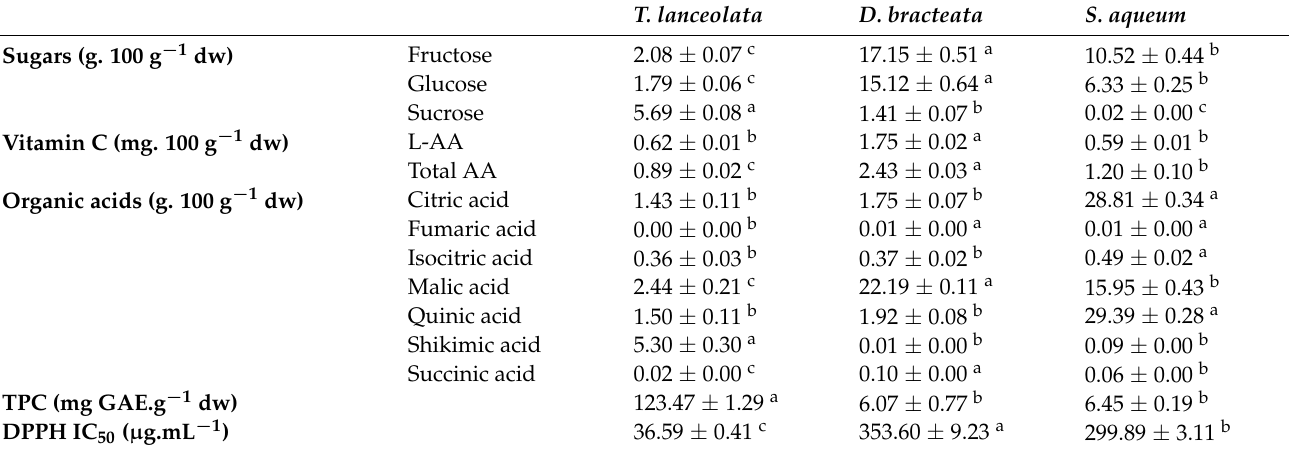
Table 3. Soluble sugars, vitamin C, organic acids, and antioxidant capacity of aqueous extracts from Tasmannia lanceolata leaves, Diploglottis bracteata fruits, and Syzygium aqueum fruits. T.